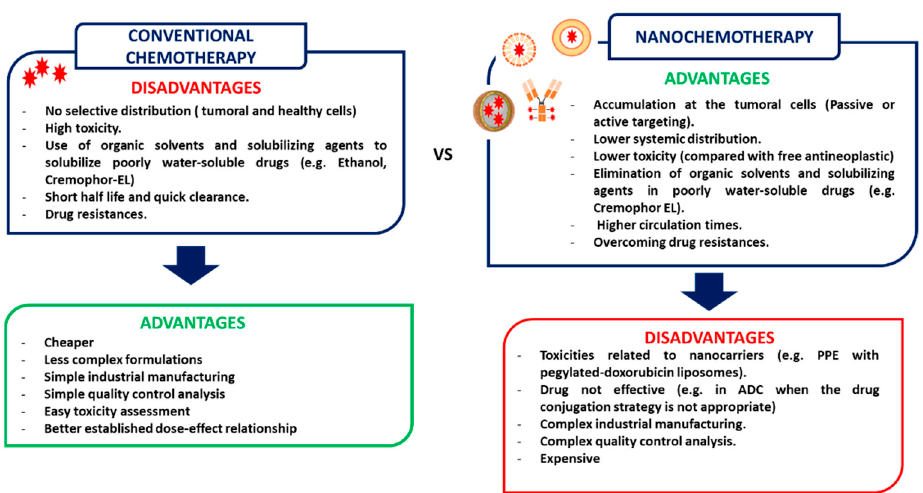
Figure 1. Scheme showing the drawbacks and advantages of both conventional chemotherapy and nanotechnology-based formulations of antineoplastics. PPE: palmar-plantar erythrodysesthesia, ADC: Antibody–drug conjugate.